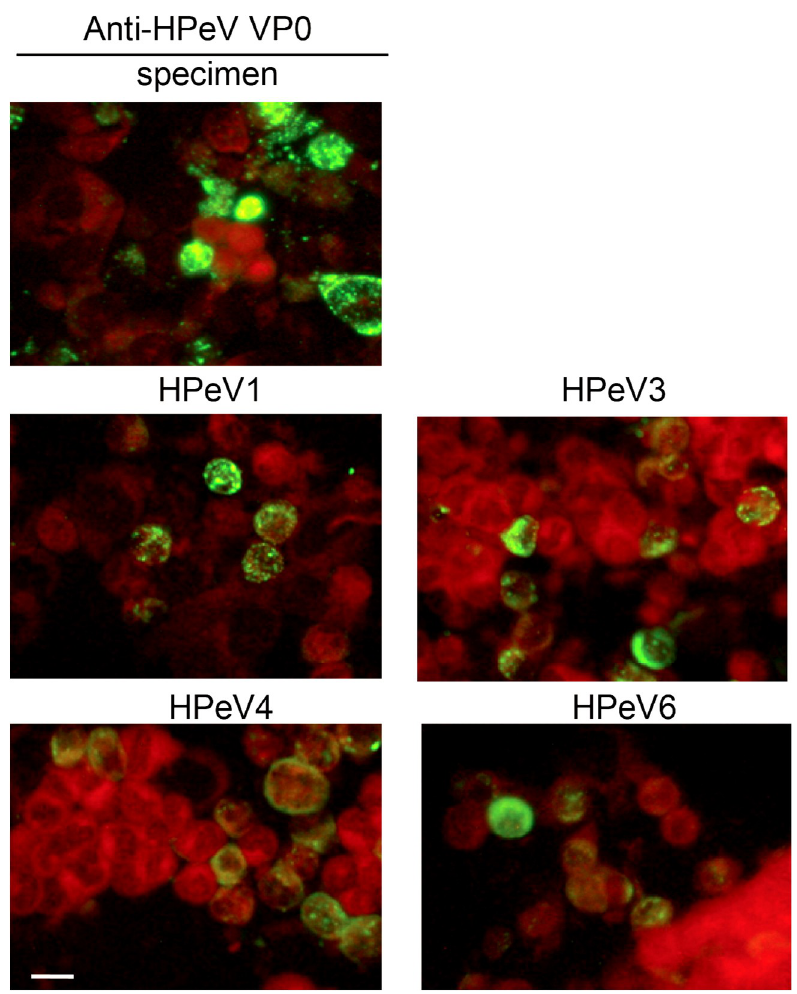
Figure 5. HPeV detection in clinical specimens from patients underwent HPeV diagnosis by IFA with anti-HPeV VP0 antibody. Green fluorescence indicates HPeV-infected cells (upper panel). Evans blue staining shows the cell location (red fluorescence). Cells infected with HPeV1, HPeV3 HPeV4 and HPeV6 were used as staining controls, s cale bar: 20 μm.